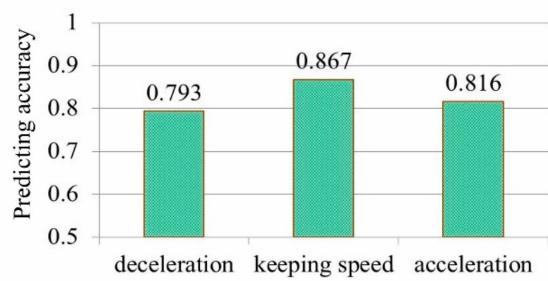
Figure 7. Accuracy in predicting driving intentions of proposed